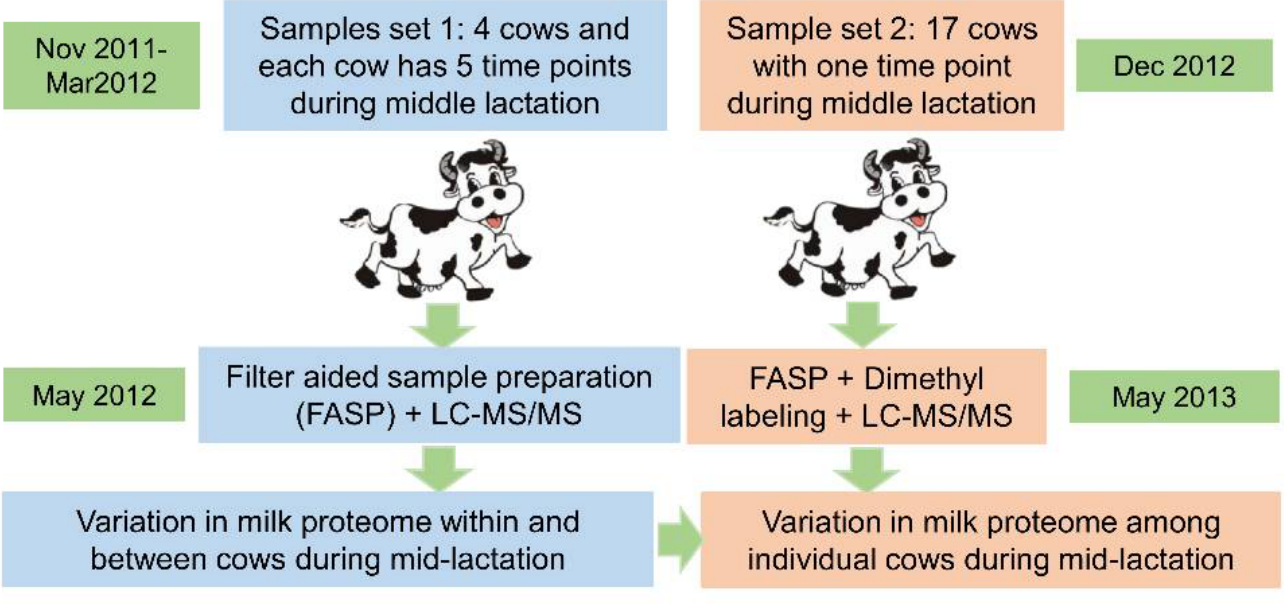
Figure 1. Experimental workflow.